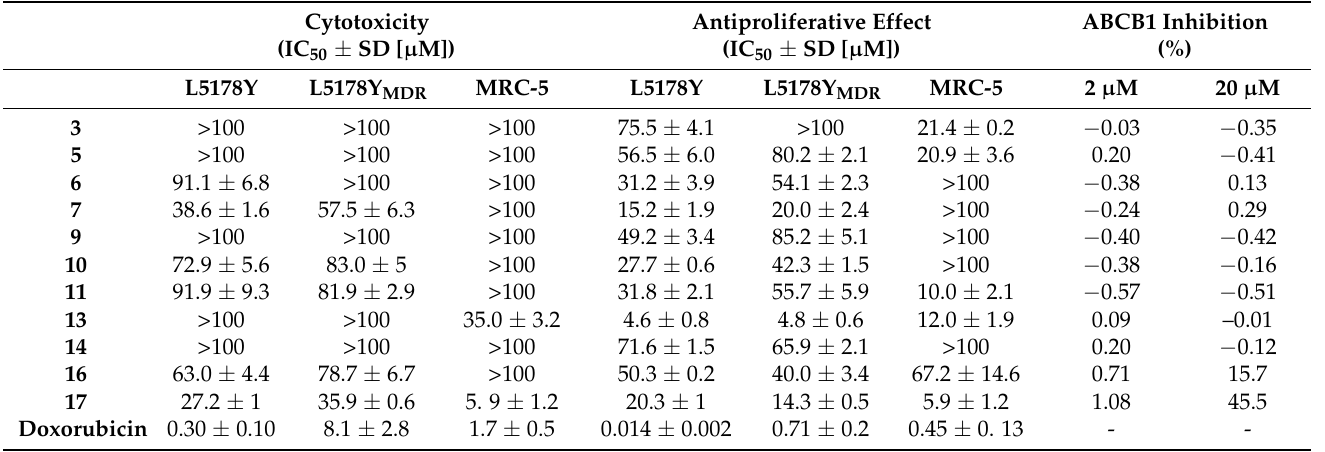
Table 3. Cytotoxicity and antiproliferative activity of compounds 3 , 5 – 7 , 9 – 11 , 13 , 14 , 16 , and 17 on mouse T-cell lymphoma cells and human fibroblasts (n = 3), and functional inhibition of the ABCB1 transporter (n = 1). For the ABCB1 inhibition, positive control: 20 nM of tariquidar (87.5% inhibition), negative control: 2% DMSO (0.2%